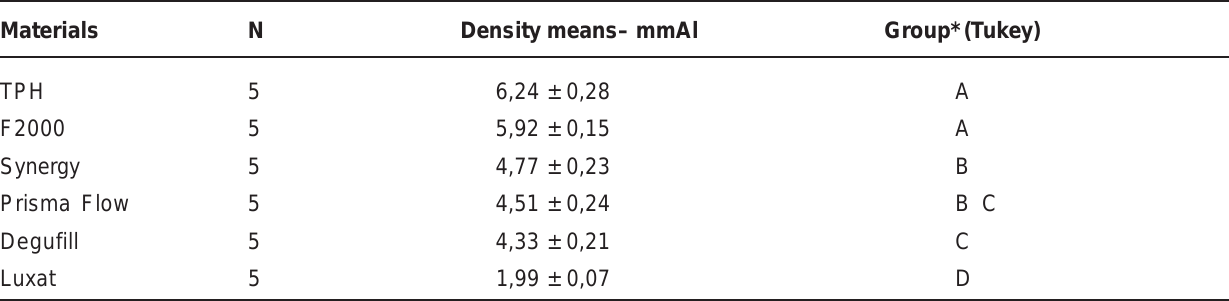
*Statistically significant difference TABLE 3- Density values of restorative materials expressed as equivalent of aluminum thickness (mmAl). Tukey’s test to compare the results among the groups